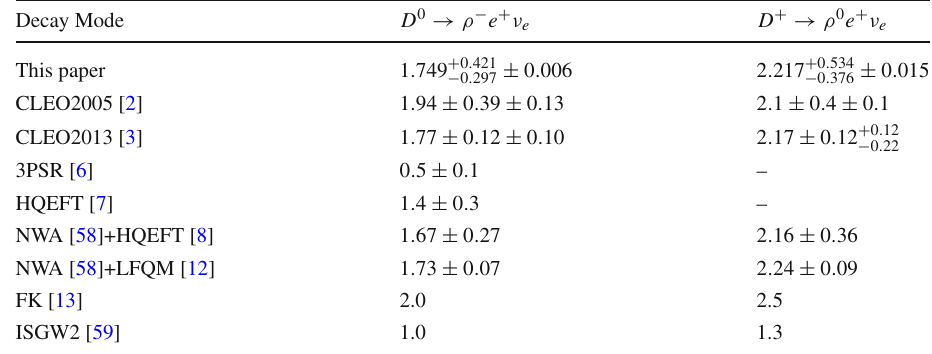
D 0 → ρ − e + ν e and D + → ρ 0 e + ν e (in unit: 10 − 3